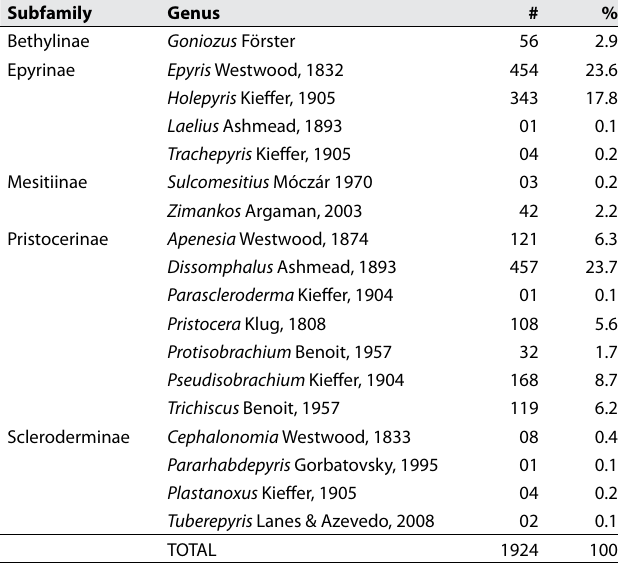
Table 1. Number (#) and frequency (%) of specimens by genus examined during this